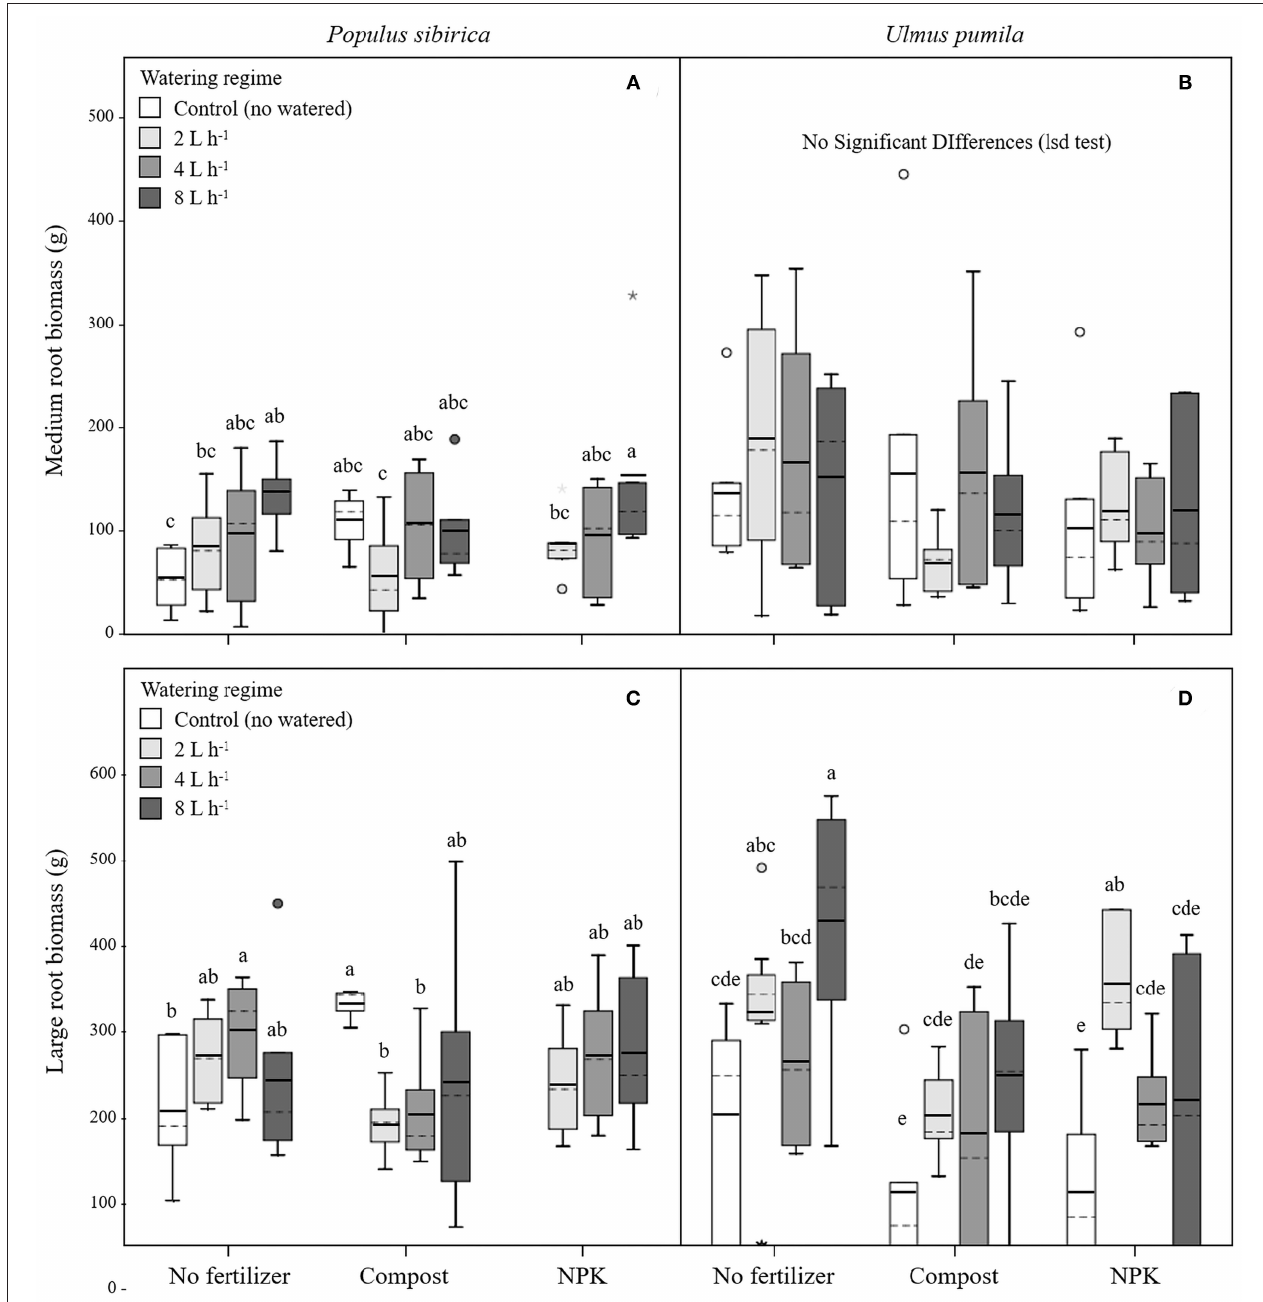
FIGURE 3 | Medium and large root biomass for P. sibirica (A,C) and U. pumila (B,D) for different watering regimes and by different fertilization treatments. Different letters indicate significant differences ( p < 0.05) among watering regimes within each fertilization treatment; absence of letters reflects that no significant difference was detected. Vertical boxes represent ∼ 50% of the observations and lines extending from each box are the upper and lower 25% of the distribution. Within each box, the solid horizontal line is the mean value and the dotted line is the median.